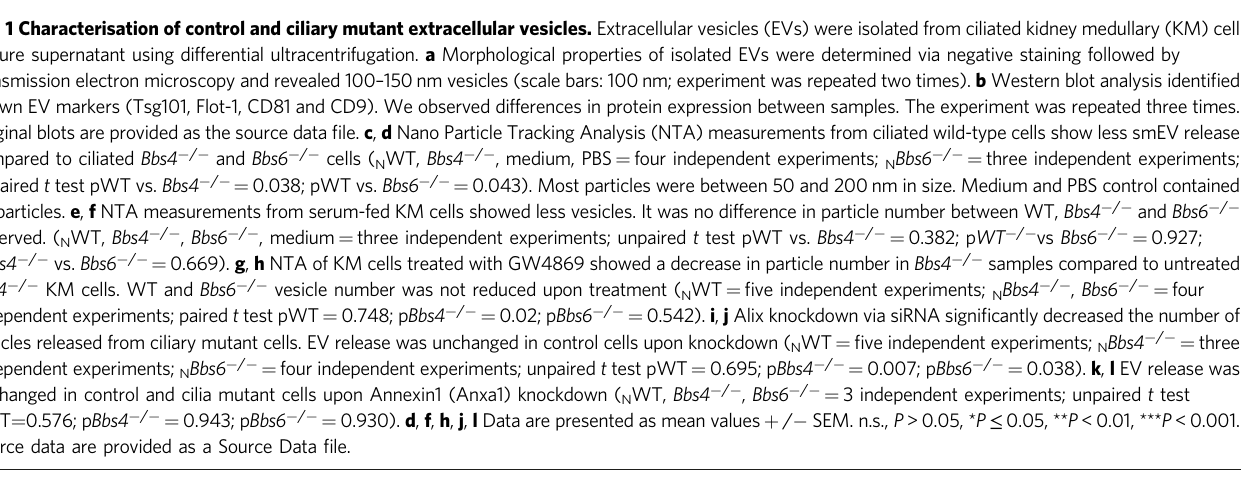
Fig. 1 Characterisation of control and ciliary mutant extracellular vesicles. Extracellular vesicles (EVs) were isolated from ciliated kidney medullary (KM) cell culture supernatant using differential ultracentrifugation. a Morphological properties of isolated EVs were determined via negative staining followed by transmission electron microscopy and revealed 100 – 150nm vesicles (scale bars: 100nm; experiment was repeated two times). b Western blot analysis identi fi ed known EV markers (Tsg101, Flot-1, CD81 and CD9). We observed differences in protein expression between samples. The experiment was repeated three times. Original blots are provided as the source data fi le. c , d Nano Particle Tracking Analysis (NTA) measurements from ciliated wild-type cells show less smEV release compared to ciliated Bbs4 − / − and Bbs6 − / − cells ( N WT, Bbs4 − / − , medium, PBS = four independent experiments; N Bbs6 − / − = three independent experiments; unpaired t test pWT vs. Bbs4 − / − = 0.038; pWT vs. Bbs6 − / − = 0.043). Most particles were between 50 and 200nm in size. Medium and PBS control